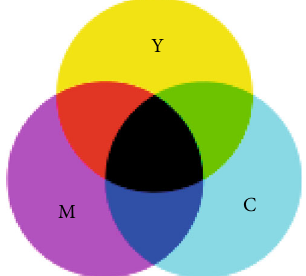
Figure 5: Graphics processing unit